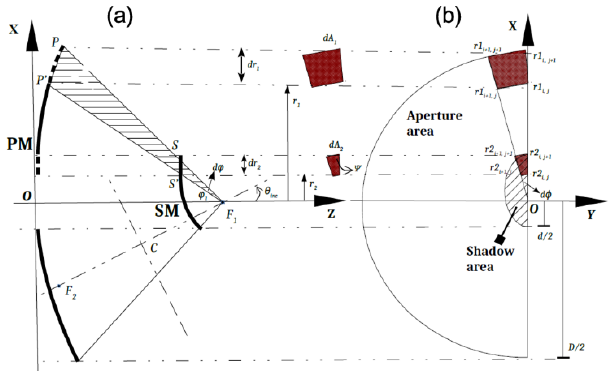
Figure 4. Geometric model of optical projection of TSD combination in the ( a ) lateral view and the ( b ) front view. In ( b ), the left half side is neglected due to symmetry. (Not to scale).